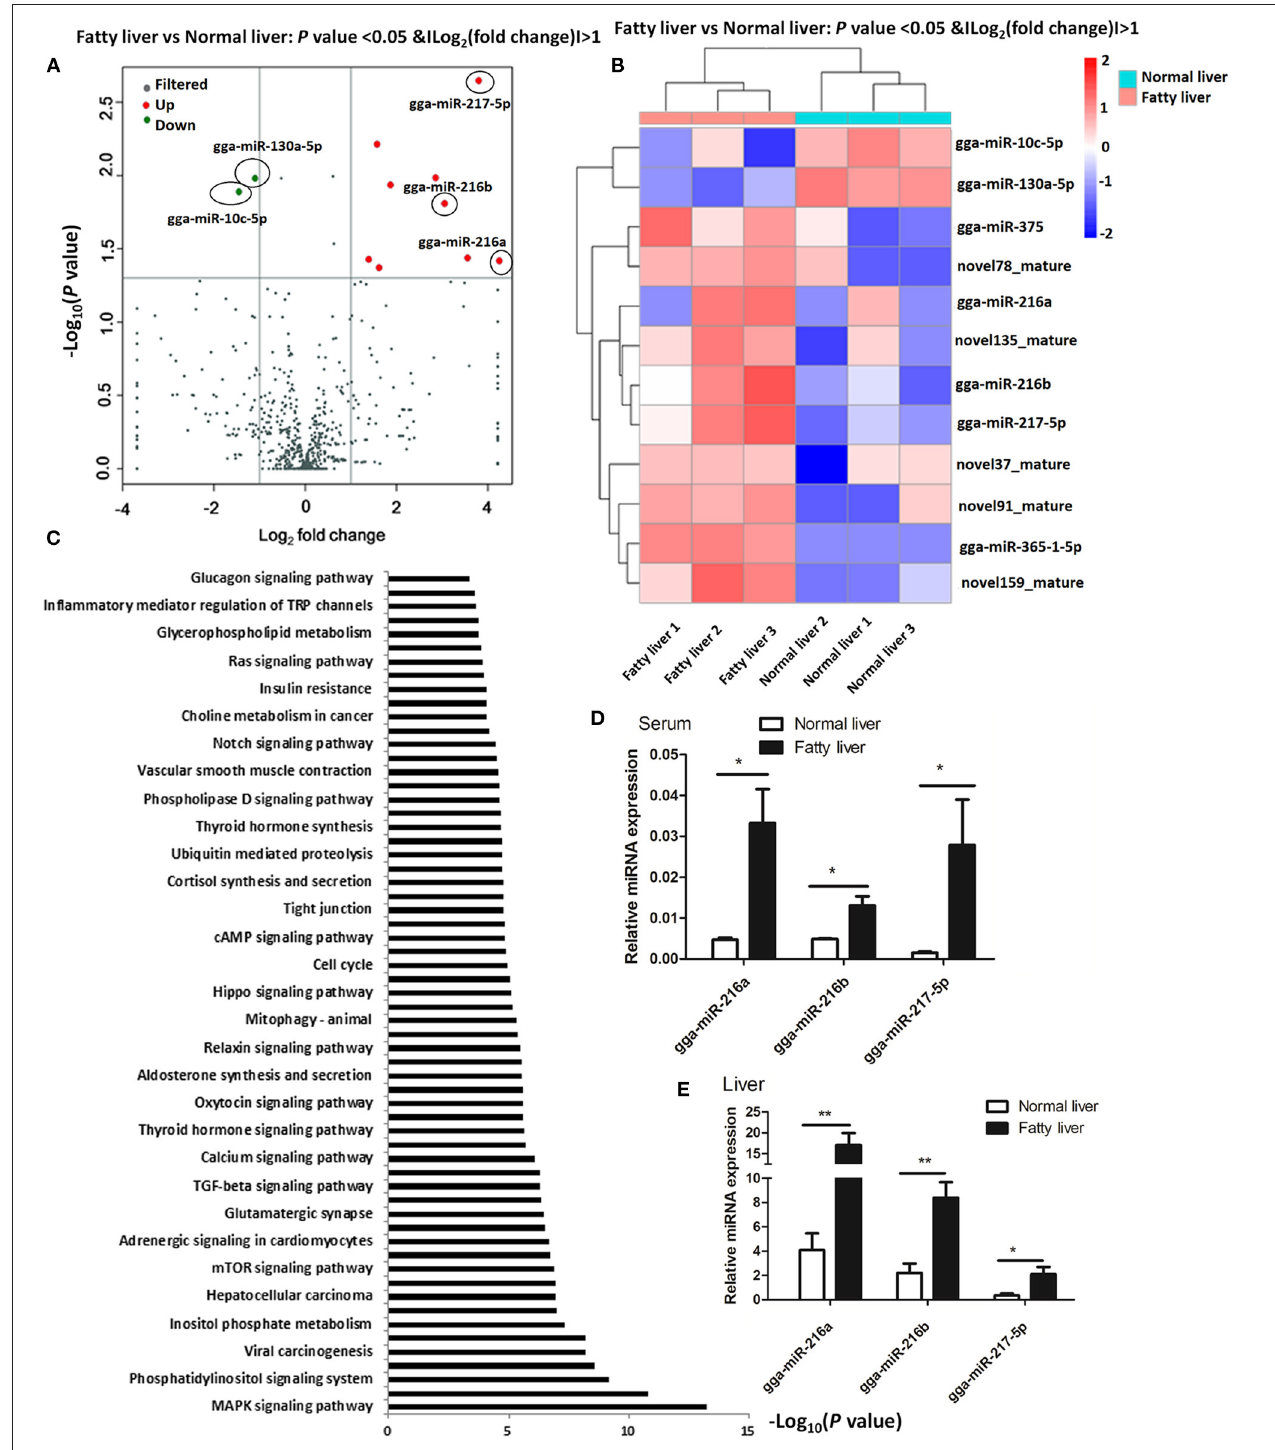
FIGURE 2 | Identification of dysregulated miRNAs in chicken fatty liver (A) Volcano plot of miRNAs in normal and fatty livers. Significantly up-regulated miRNAs are shown in red and significantly down-regulated miRNAs in green. (B) Heat map of miRNAs in normal and fatty livers. (C) Function enrichment analysis of biological pathways for target genes of the 12 modulated miRNAs (fold change > 2). (D,E) Expression levels of selected miRNAs in sera and livers. * P < 0.05 and ** P < 0.01.